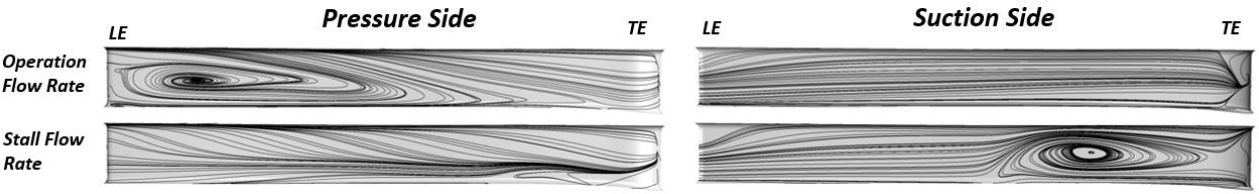
Figure 6. Surface streamlines indicating flow separation zones on diffuser vane surfaces.